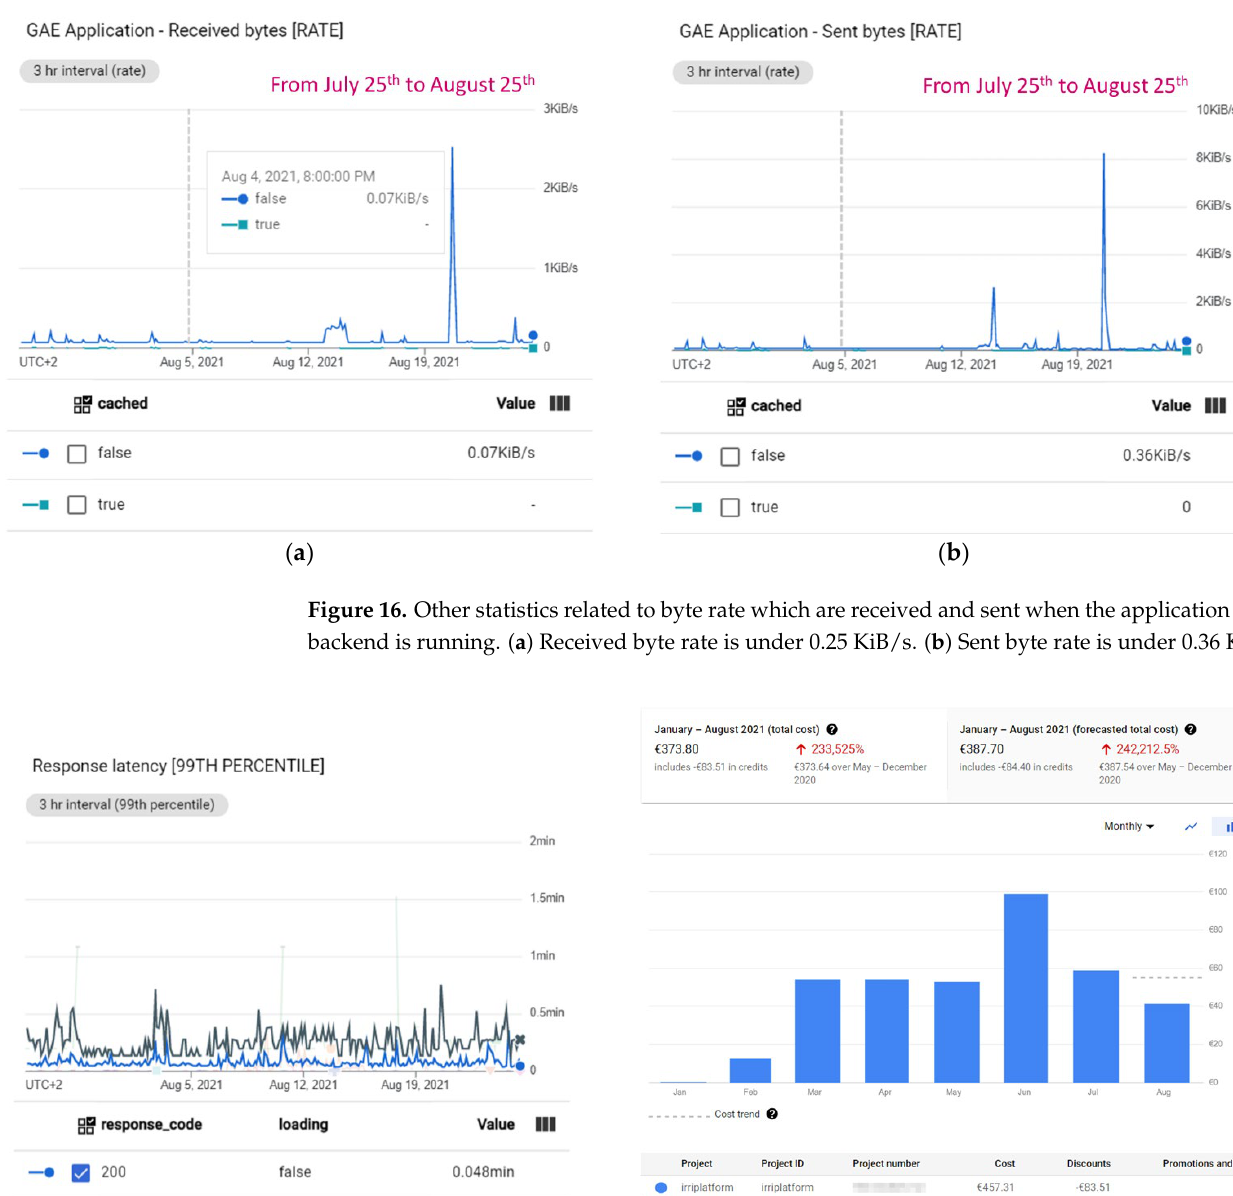
Figure 15. Summary of statistics about the use of the Datastore, while the application is running in the backend for all the users. Information about number of stored entities, data size and global size is automatically calculated.